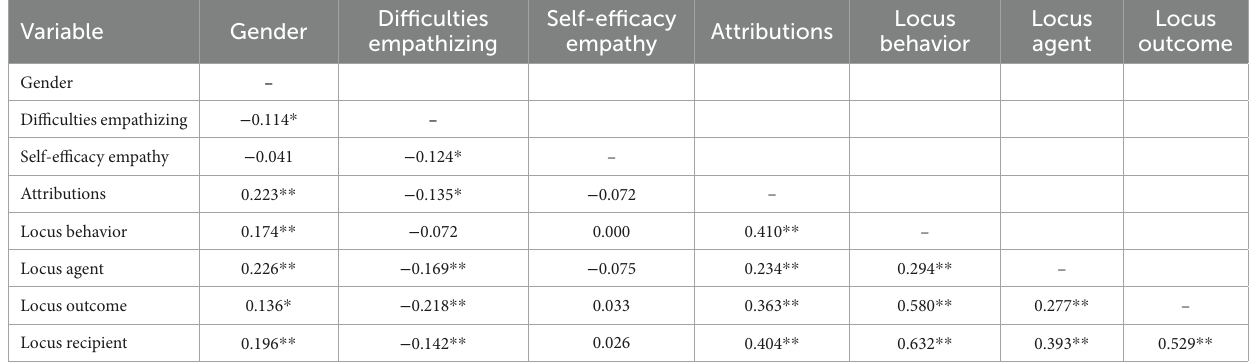
TABLE 4 Correlations between EQVC and PMDCI.